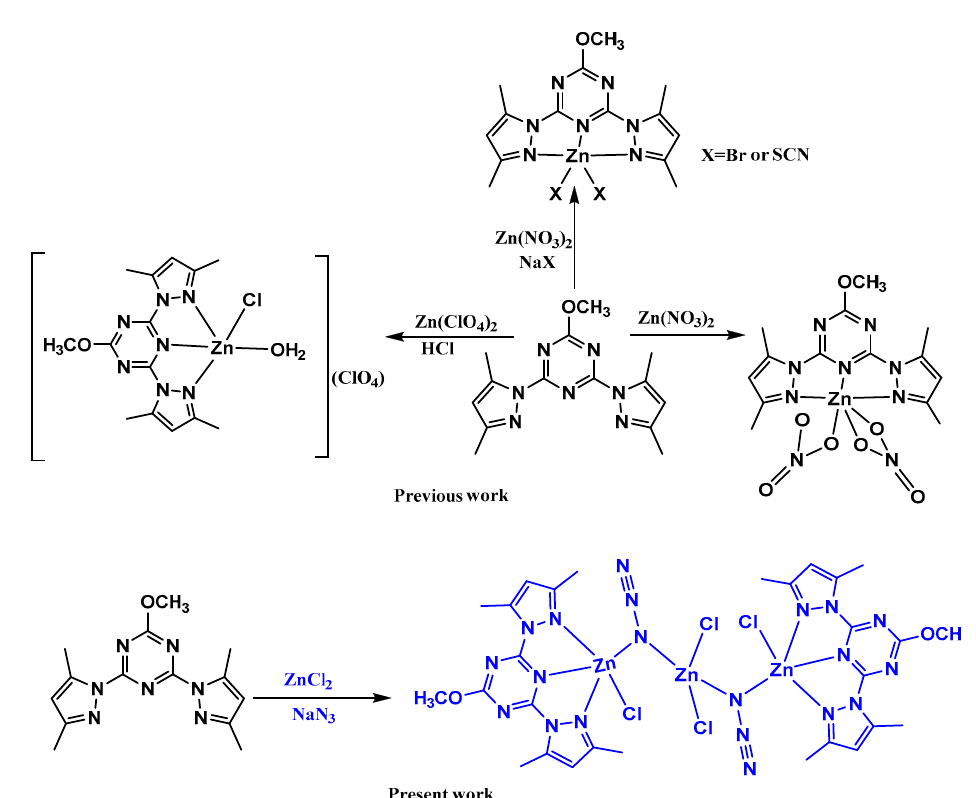
Scheme 2. Synthesis of different Zn(II) complexes with different anions. Table 1. Crystallographic data for the [Zn 3 (PMT) 2 (Cl 4 )(N 3 ) 2 ]